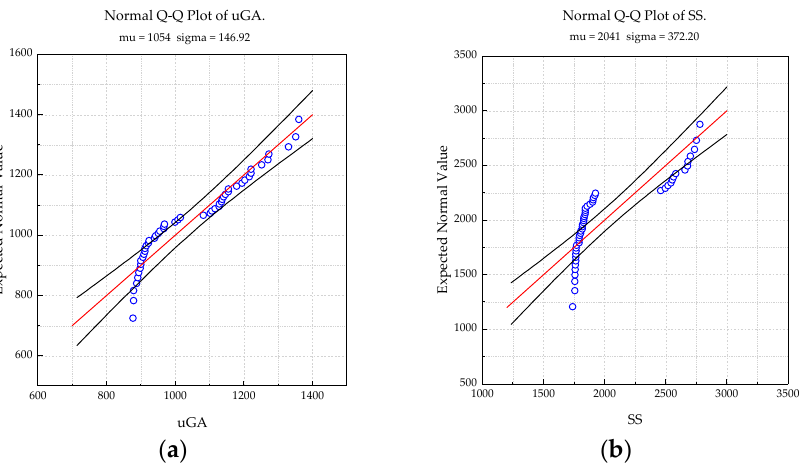
Figure 5. Quantile–quantile (Q–Q) plots of the time cycles spent by uGA and SS. The thin gray lines are the upper and lower percentile lines with a confidence level of 95%. ( a ) Normal Q–Q plot of the time cycles spent by uGA; ( b ) normal Q–Q plot of the time cycles spent by SS.